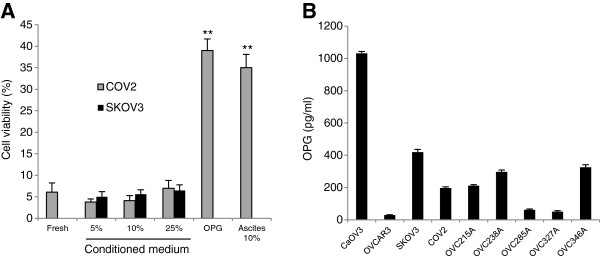
Conditioned medium from OC cells do not suppress TRAIL-induced cell death. CaOV3 cells were challenged with TRAIL (50 ng/ml) and either fresh medium (Fresh), 5-25% SKOV3 or COV2 conditioned medium, or OPG (25 ng/ml) or ascites (10%) for 48 h, and cell viability was determined by XTT assay. Data are expressed as means of triplicates from three independent experiments ± SD. ** P < 0.001 compared to control. (B) OPG concentrations in the cell supernatant of TRAIL sensitive OC cell lines CaOV3 and OVCAR3, TRAIL resistant OC cell lines SKOV3 and COV2, and human primary ovarian tumor cells OVC215A, OVC238A, OVC285A, OVC327A and OVC346A were measured by ELISA after culture of confluent cells for 48 h.